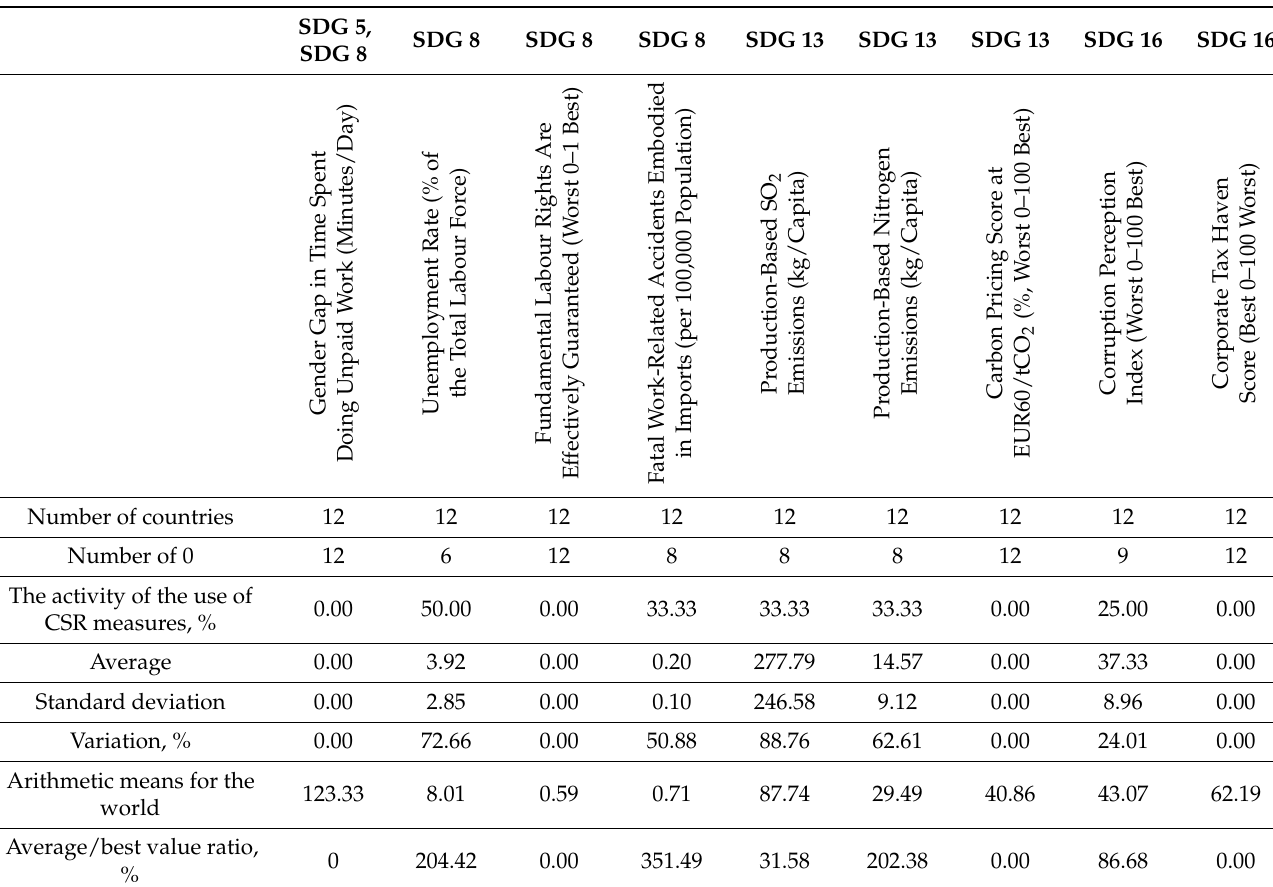
Table 9. Representation of the CSR practices to support the SDGs (UN standards) in countries of Oceania in